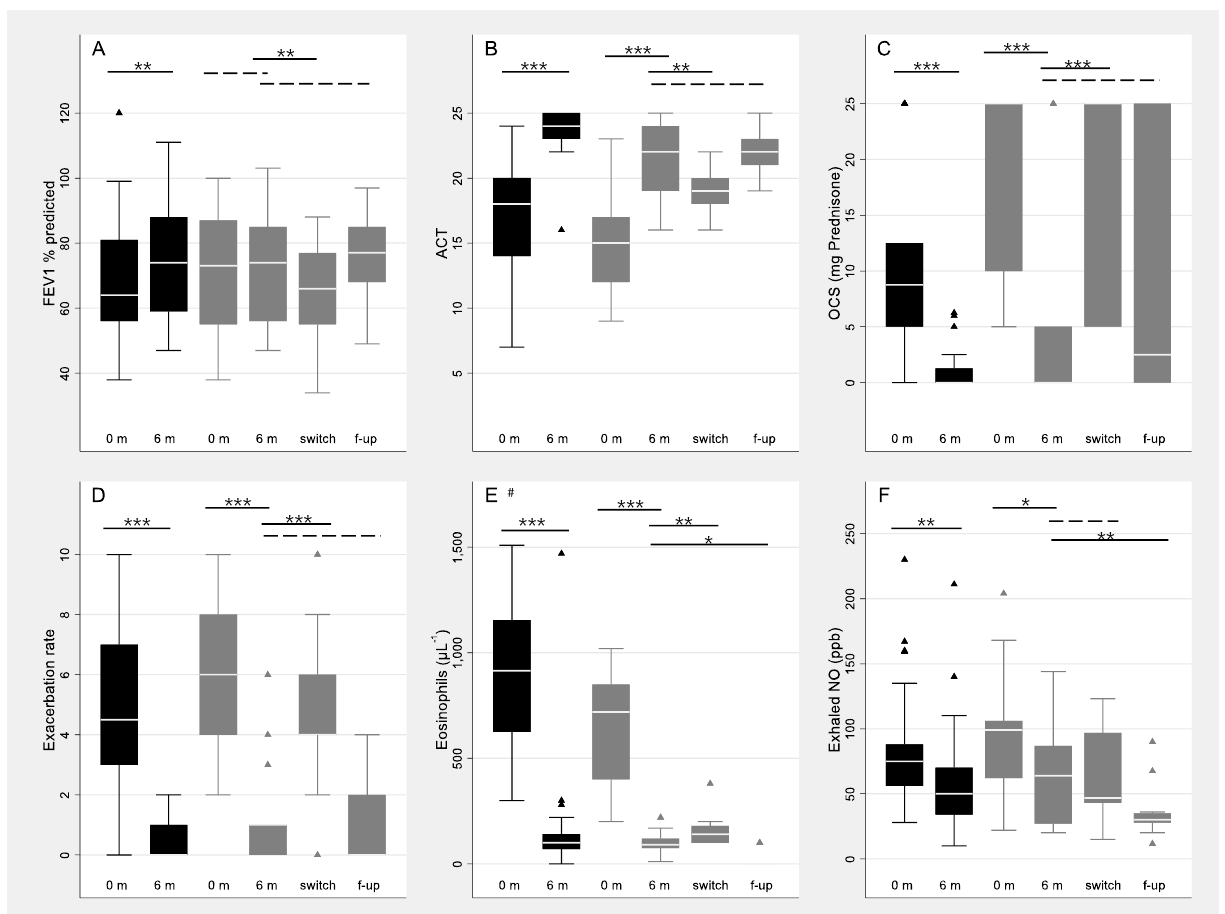
Figure 1. Distribution of clinical characteristics of patients (( A ): lung function expressed as FEV1%; ( B ): ACT—Asthma Control Test; ( C ): Oral Corticosteroid daily intake, expressed as mg of prednisone; ( D ): asthma exacerbation rate; ( E ): blood eosinophils count; ( F ): Fractional Exhaled Nitric Oxide) at baseline and follow-up examinations by subgroup: non-switch (black boxes) and switch (grey boxes). 0 m, baseline examination; 6 m, examination at 6 months; switch, examination at the time of switching; f-up, final follow-up examination; triangles represent outliers; * p < 0.05, ** p < 0.01, *** p < 0.001 for comparisons with the examination at 6 months; dashed lines indicate p > 0.05. #, one point omitted for graphical reasons (eosinophils = 15,000 per µL for one patient of the non-switch subgroup, baseline examination).